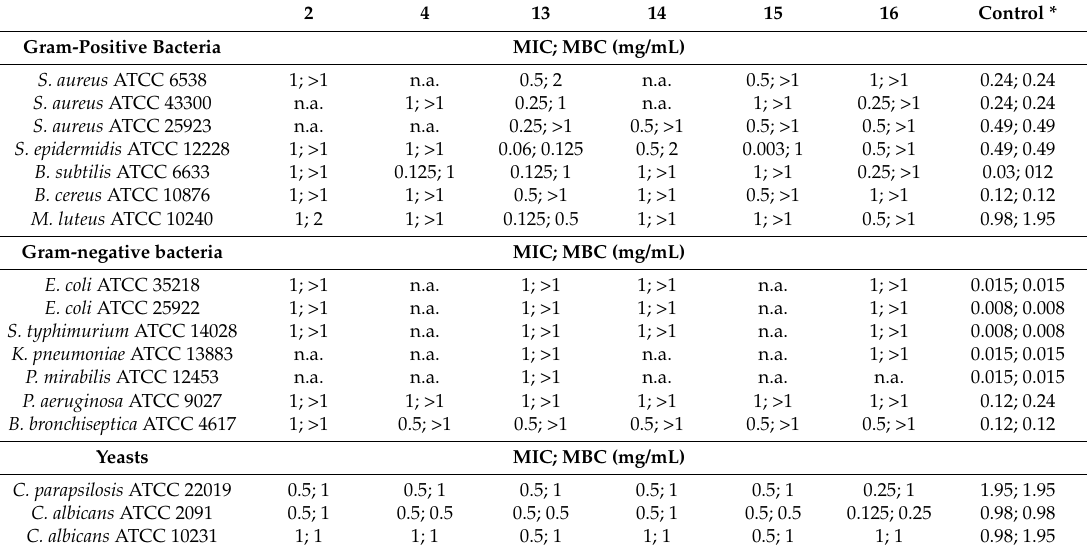
Table 1. Antimicrobial data (minimal inhibitory concentration (MIC) and minimum bactericidal concentration (MBC), mg/mL) for 2 , 4 , 13 – 16